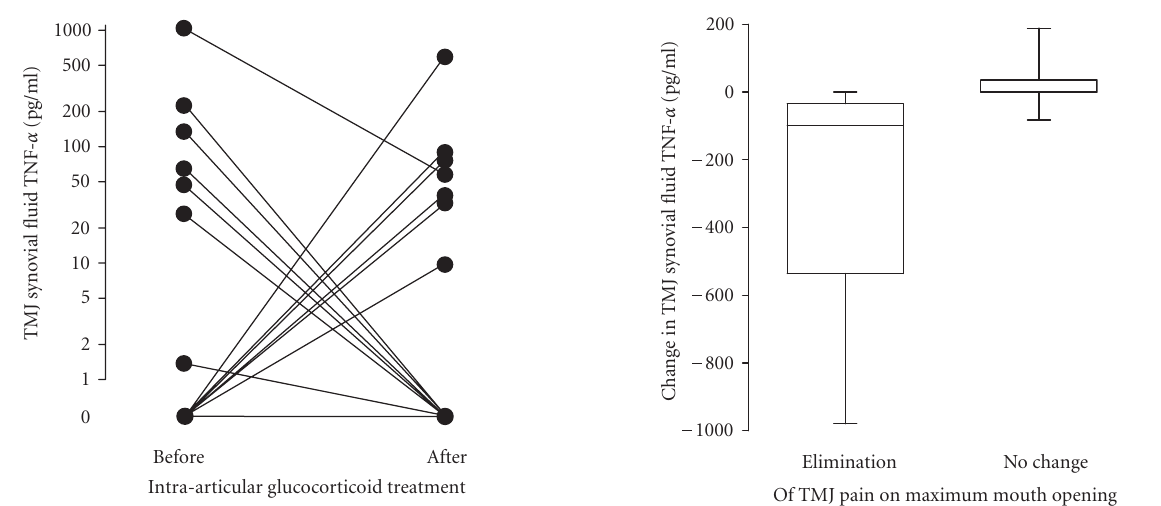
Figure 3: Box-plot (10th, 25th, 50th, 75th, and 90th percentiles) showing the relation between change in presence of temporo- mandibular joint (TMJ) pain upon maximum mouth opening and change in synovial fluid level of tumor necrosis factor- α (TNF- α ) after intra-articular glucocorticoid treatment in 21 female patients with chronic TMJ inflammatory disorders ( r s = 0 . 50, n = 21, P = . 020). Four patients had an elimination and 17 had no change of TMJ pain upon maximum mouth opening. In the 7 patients with detectable pretreatment levels, 3 experienced an elimination and 4 no change in TMJ pain upon maximum mouth opening.